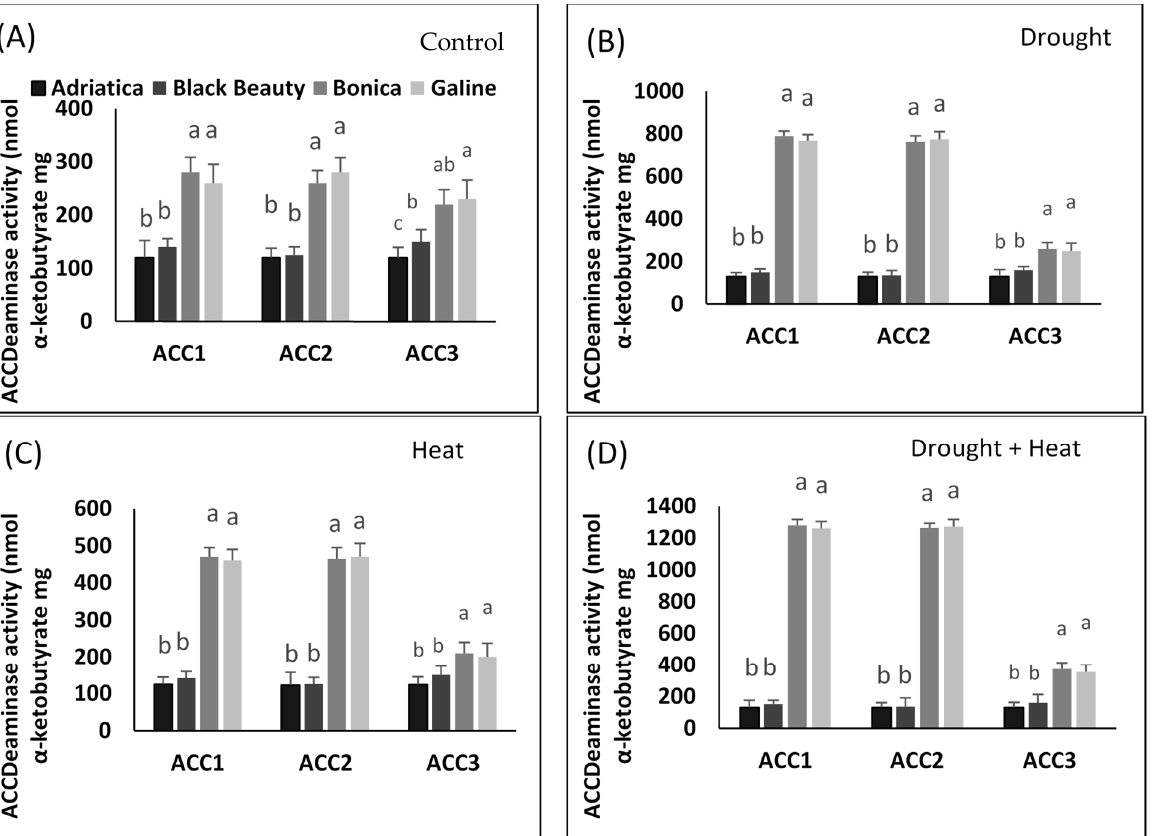
Figure 9. ACC deaminase activity (nmol α -ketobutyrate mg protein − 1 h − 1 ) determined by individual and combined stresses of four isolates from four eggplant cultivars’ roots: ( A ) (Control), ( B ) (Drought), ( C ) (Heat), and ( D ) (Drought + Heat). Values are means of five repetitions ± SE ( n = 5). Significant dissimilarities are shown by different lower-case letters between treatments ( p ≤ 0.05) based on Tukey’s test.